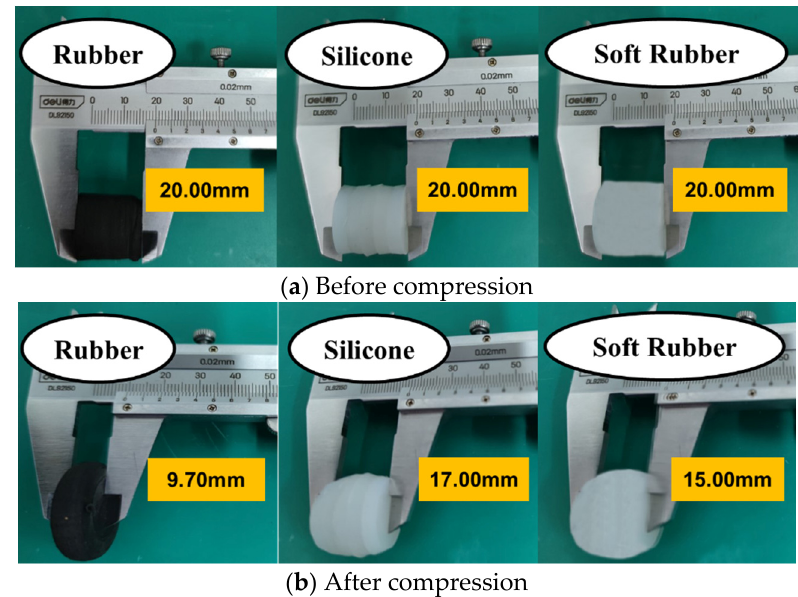
Figure 6. Uniaxial compression result: ( a ) before compression; ( b ) after Compression.